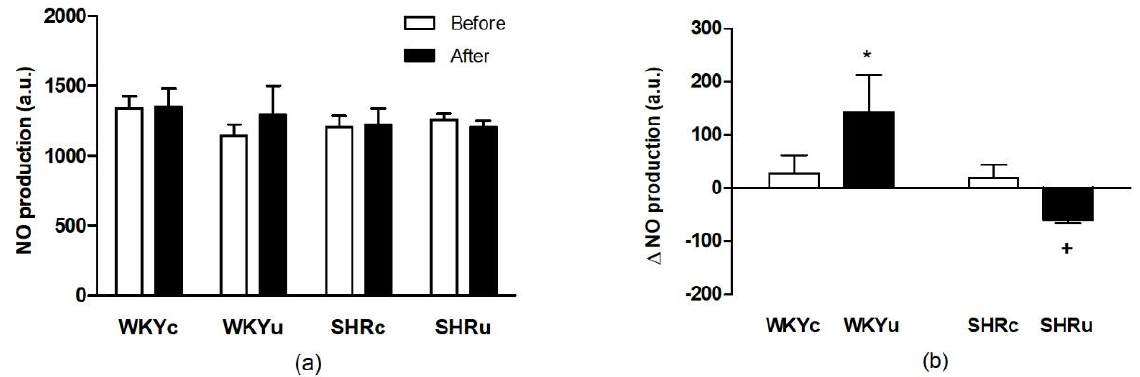
Figure 2. Nitric oxide production by red blood cells determined before and after the single USPIONs administration at tahe dose of 1 mg Fe/kg body weight ( a ) and the difference in nitric oxide production by red blood cells measured after the USPIONs administration and before it ( b ). Rats were killed approximately 100 min after the USPION administration. Abbreviations: NO, nitric oxide; USPIONs, ultra-small superparamagnetic iron-oxide nanoparticles; WKY, Wistar Kyoto rats; SHR, spontaneously hypertensive rats; WKYc, control WKY; WKYu, USPION-treated WKY; SHRc, control SHR; SHRu, USPION-treated SHR. The data are presented as means ± SD, n = 6–7 per group; * p < 0.05 vs. WKYc; + p < 0.05 vs. WKYu.